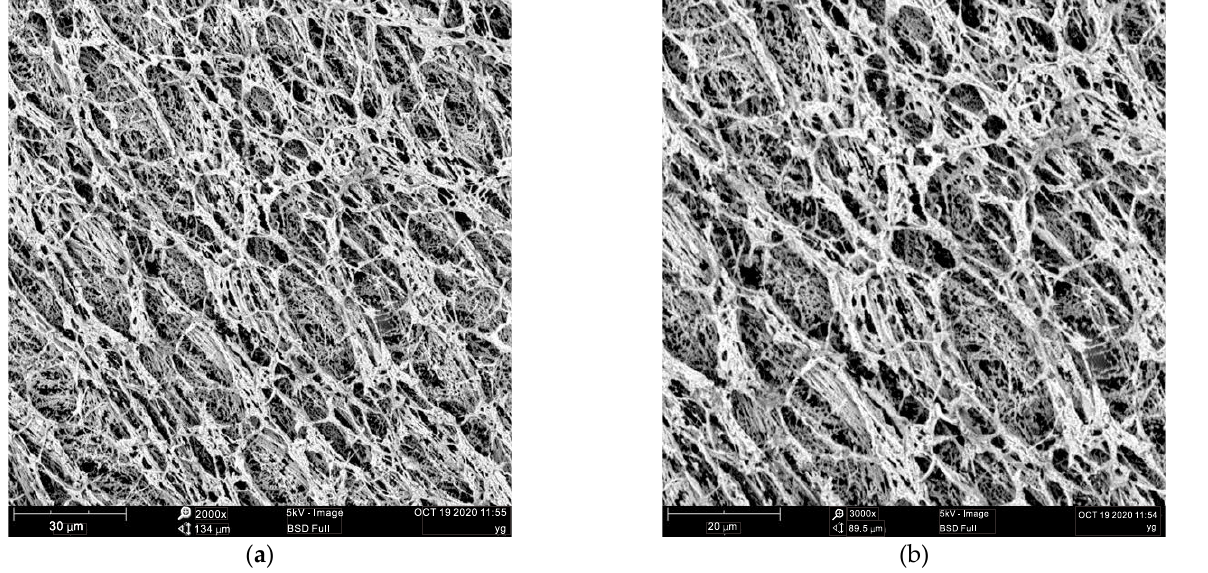
Figure 6. Electron micrograph of a polymer fluid: ( a ) 2000 times magnification; ( b ) 3000 times magnification.